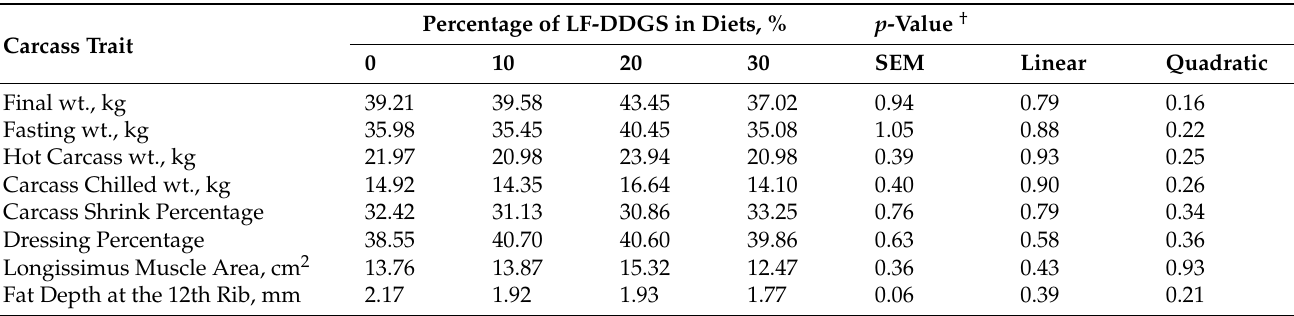
Table 5. Carcass characteristics of the castrated male goats fed diets with different percentages of low-fat distillers dried grains with Solubles (LF-DDGS) for 84